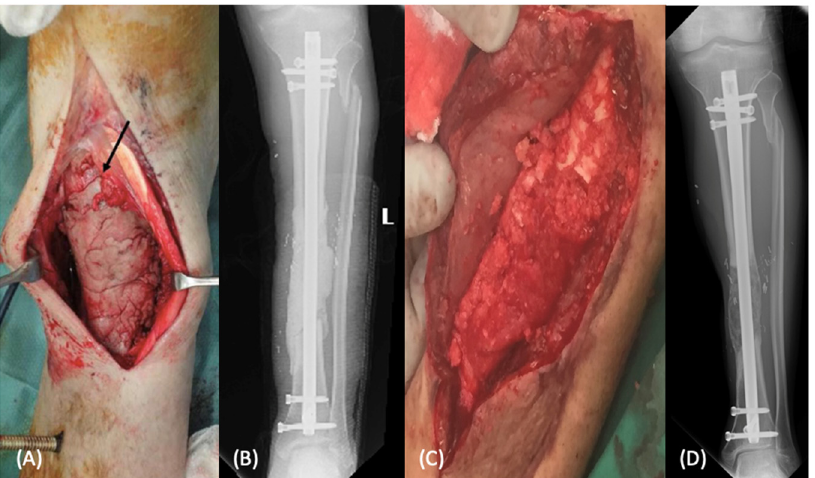
Figure 1. Masquelet technique for diaphyseal tibial defect demonstrated in intraoperative photos of the antibiotic spacer placement ( A ) with post-operative radiographs ( B ). The patient underwent subsequent second stage autologous bone grafting into induced membrane ( C ) with post-operative radiographs seen in image ( D ).